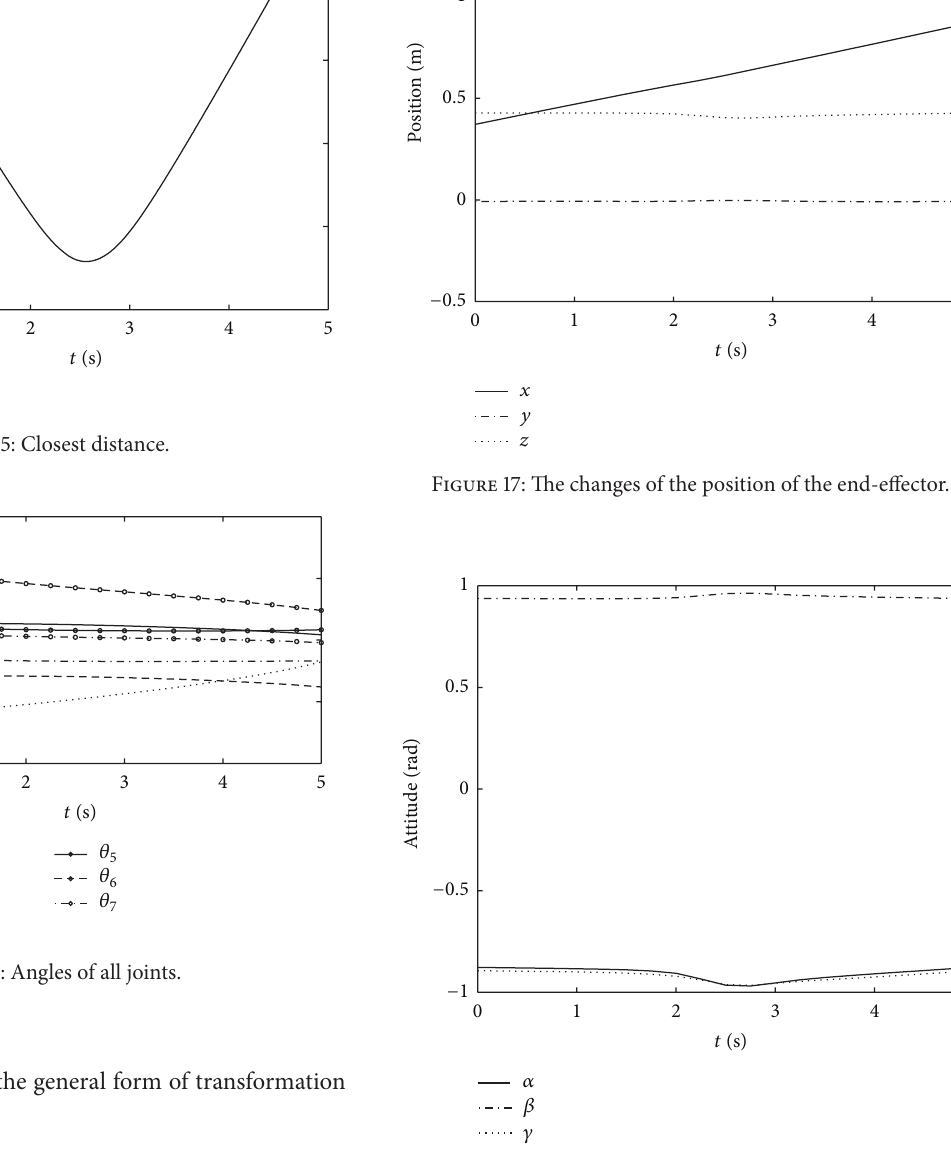
Figure 18: The changes of the attitude of the